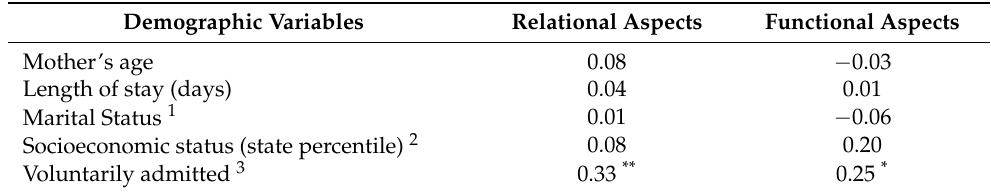
Table 5. Spearman Correlations Between Demographic and Diagnostic Variables with PREM Subscales.